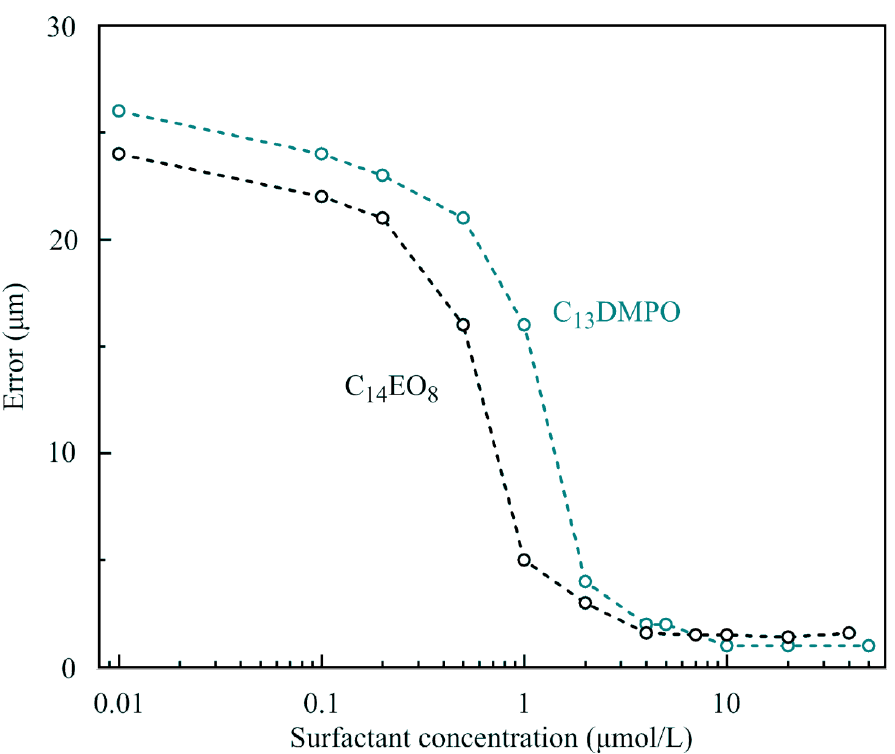
Figure 13. Dependence of Error on surfactant concentration for C 14 EO 8 and C 13 DMPO solutions. Dashed lines are guides for the eye.